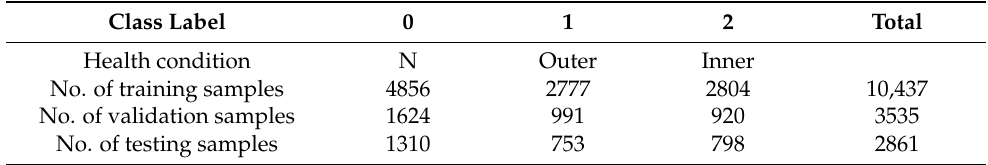
Table 7. Description of the MFPT